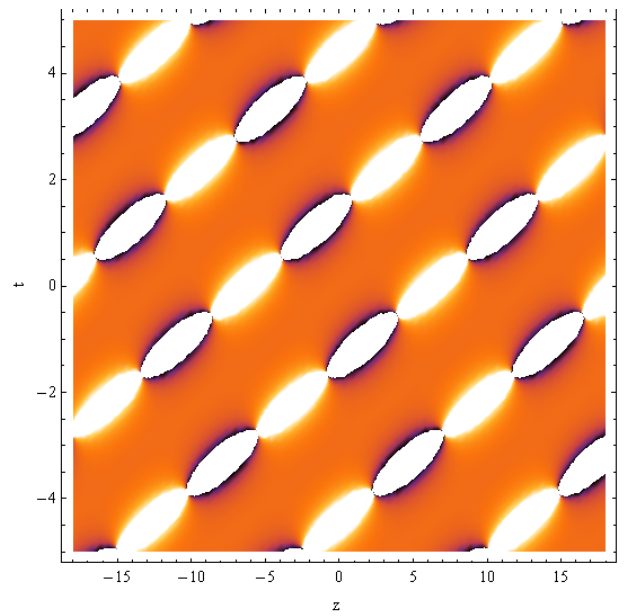
Figure 5. Change of real part of solution (16) with z , t for c = 0.5, v = 0.7, β 1 = 0.1, β 2 = 1, β 3 = 0.3, β 4 = 0.2.